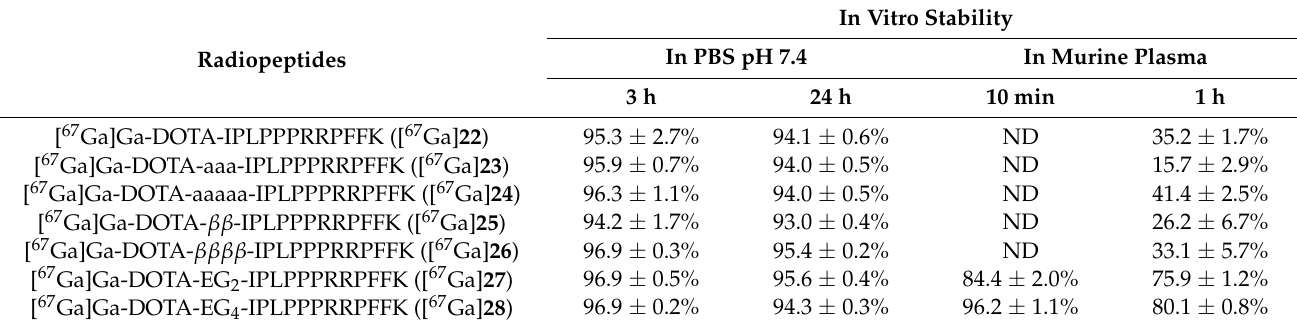
Expressed as percentage of remained intact of radiotracer. Data were presented as the mean (SD) for three samples. ND: not determined. Table 3. Comparison of the cellular uptake of [ 67 Ga]Ga-DOTA-(linker)-IPLPPPRRPFFK (linker = none, aaa, aaaaa, ββ , ββββ , EG 2 , EG 4 ) into BxPC3- luc cells.